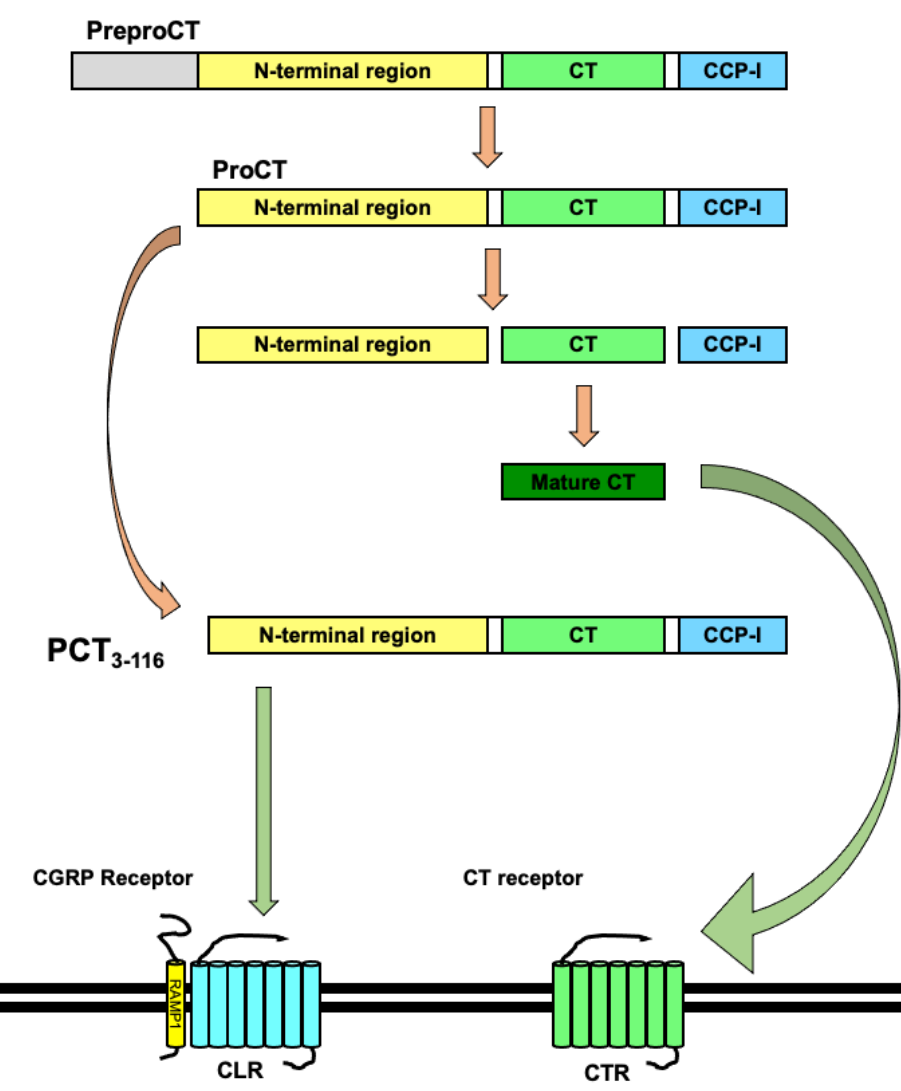
Figure 1. Calcitonin (CT), procalcitonin (PCT), and receptors of CT and PCT. The cleavage of preproCT and the release of the signal peptide produces PCT. The cleavage of PCT generates aminopro- CT, immature CT, and calcitonin carboxypeptide-1 (CCP-I). Immature CT is converted into mature CT by post-transcriptional modifications (disulfide bridge between Cys 1 and Cys 7 and amidation of C-terminus) and binds to the CT receptor (CTR). PCT is converted into PCT 3-116 , which binds to the CGRP receptor, which is composed of a heterodimer of the CTR-like receptor (CLR) and receptor activity-modifying protein 1 (RAMP1). Processing of PCT 1-116 is catalyzed by dipeptidyl-peptidase 4 (DPP-4), which cleaves the N-terminal dipeptide Ala 1 -Pro 2 of PCT 1-116 , resulting in the generation of a 114-amino acid-long, truncated form (PCT 3-116 ) [47]. In addition, PCT 3-116 is considered the main form of PCT in the serum during sepsis [48,49]. At the endothelial cell surface, the DPP-4- cleaved PCT 3-116 activates the CGRP receptor (CLR heterodimerized with RAMP1) and